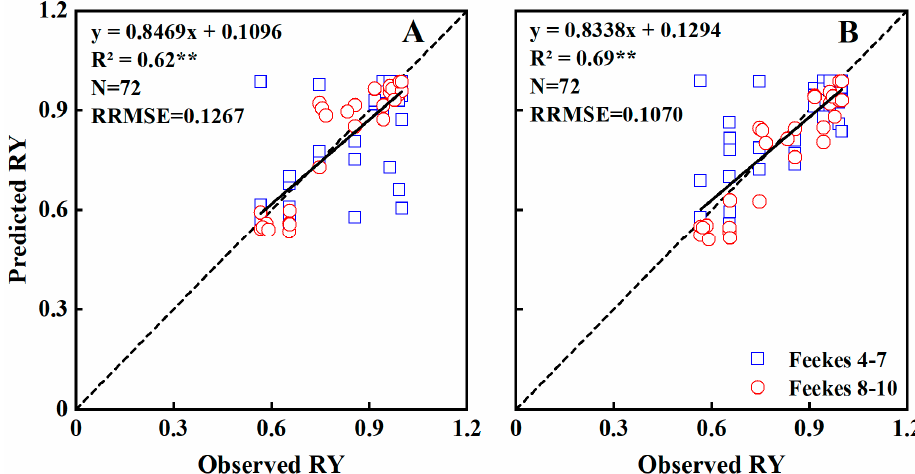
Figure 11. The relationships between observed and predicted RY values of wheat varieties based on rNDVI ( A ) and rRVI ( B ) models in the Experiment 4 during vegetation growth period. The dotted line is inclined at 45° to the axes.